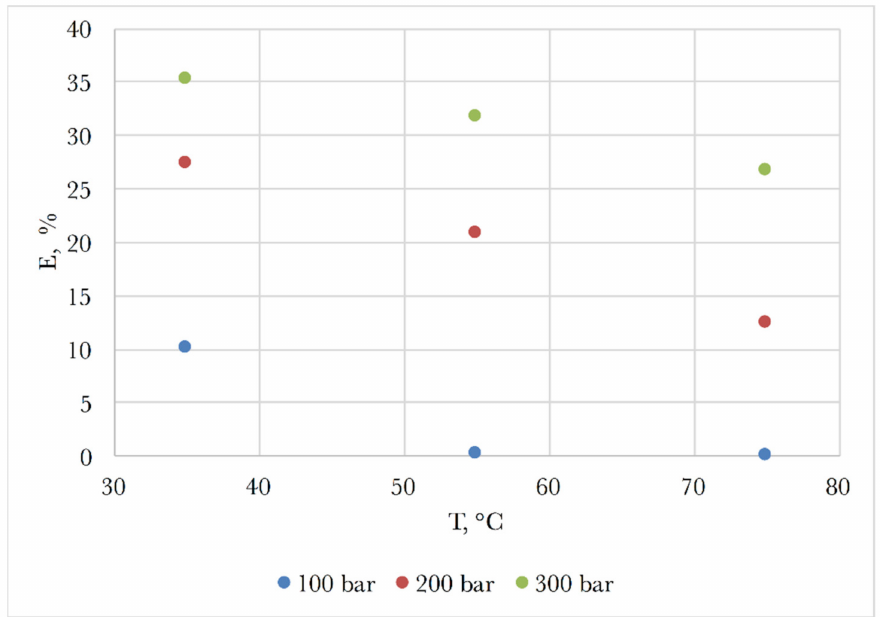
Figure 2. Dependence of caffeine extraction ratio on SC-CO 2 pressure and temperature.